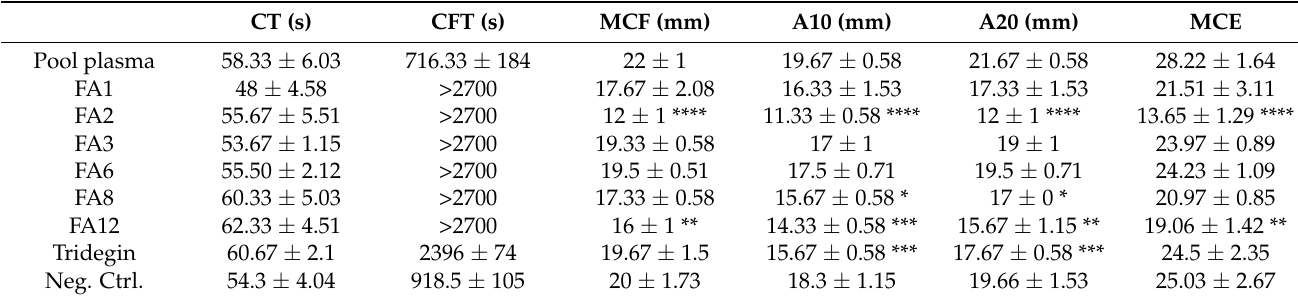
Figure S3 and Supplementary Materials, Table S2). The minor changes in A20-, LI30-, and LOT-values which were observed after addition of other aptamers to the pool plasma were not statistically significant. Table 3. Results of rotational thromboelastometry (ROTEM) analysis of plasma samples spiked with 2 µ M of different aptamers or